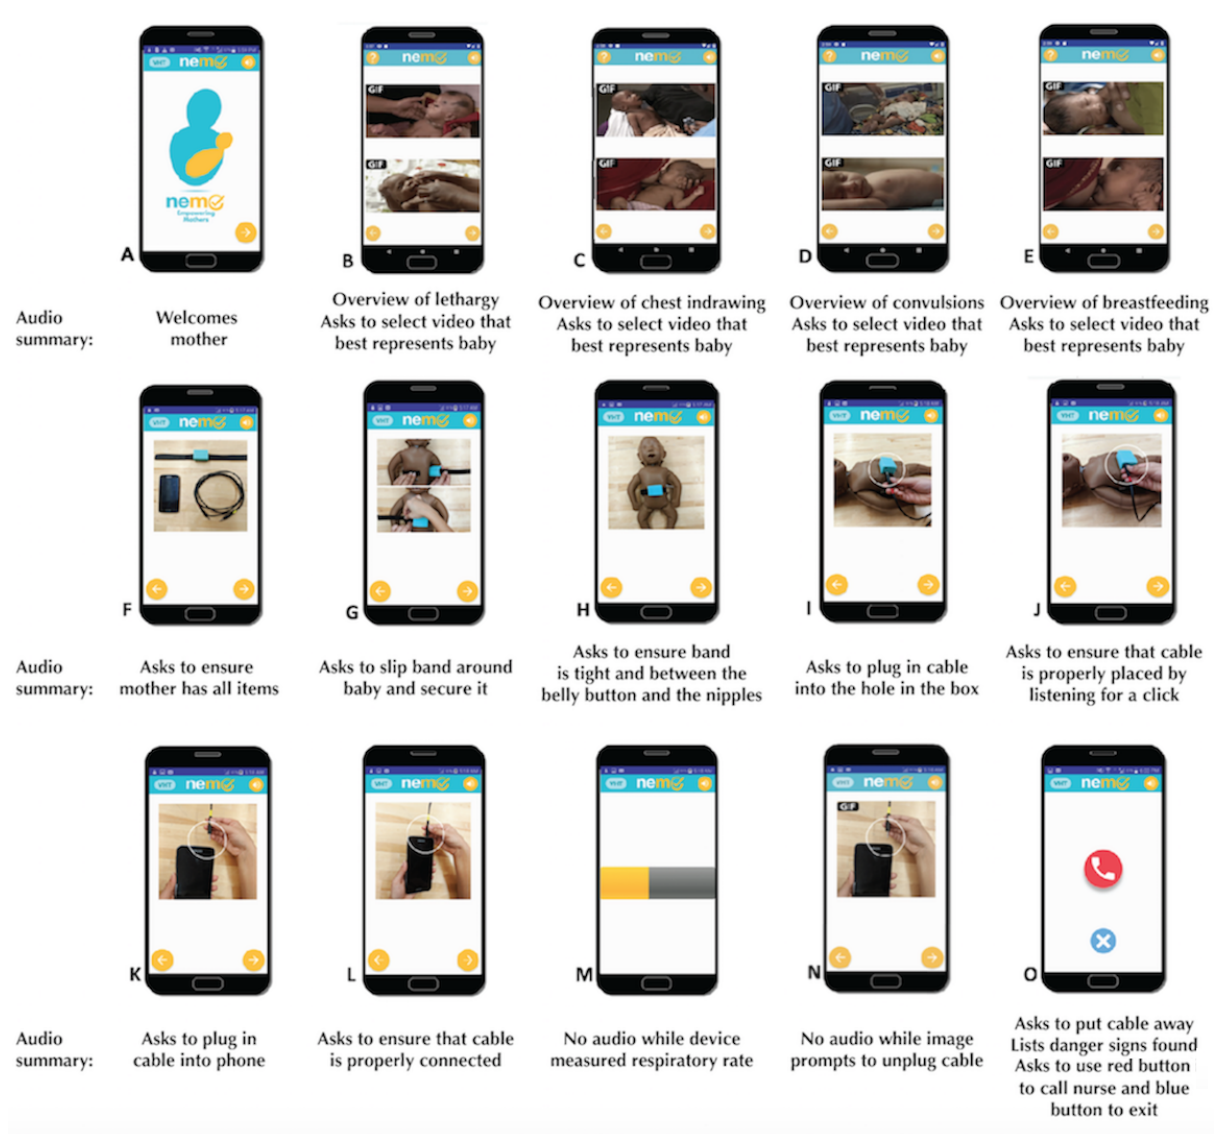
Figure 2. The user interface of the NeMo